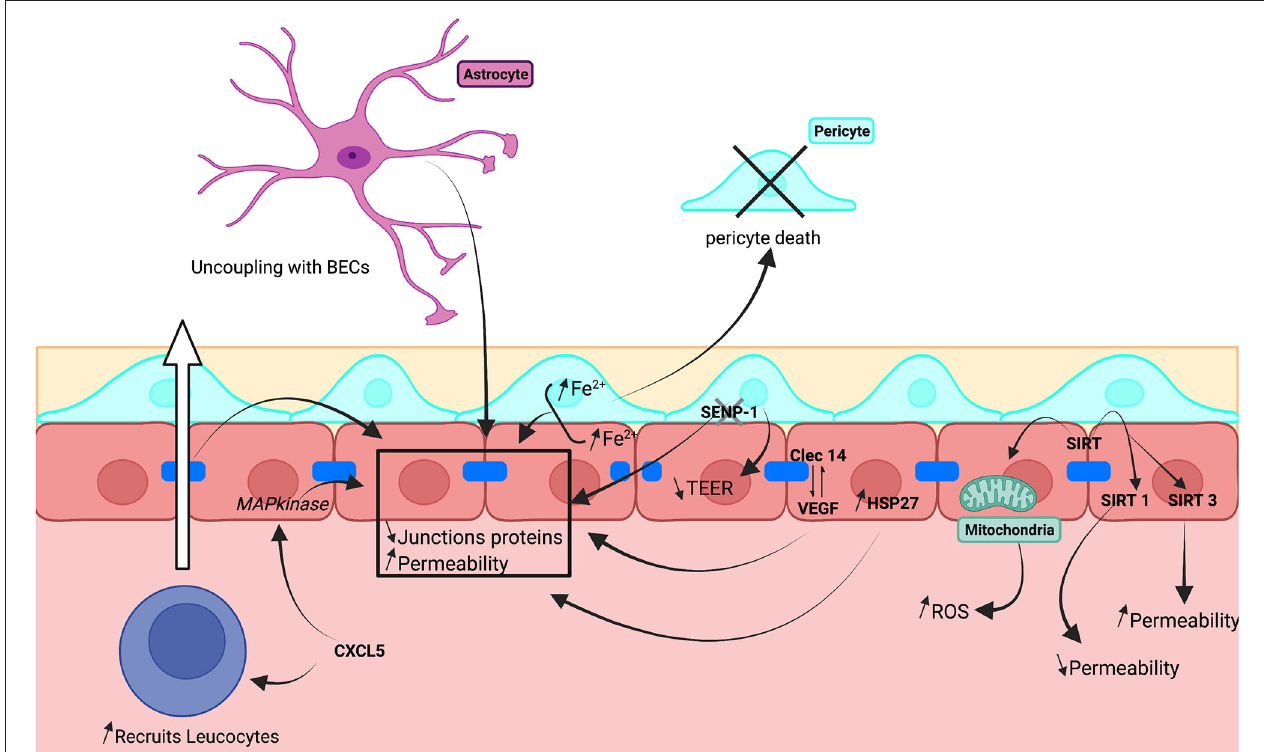
FIGURE 6 | Schematic illustration of cerebrovascular dysregulation on in vitro human BBB models.